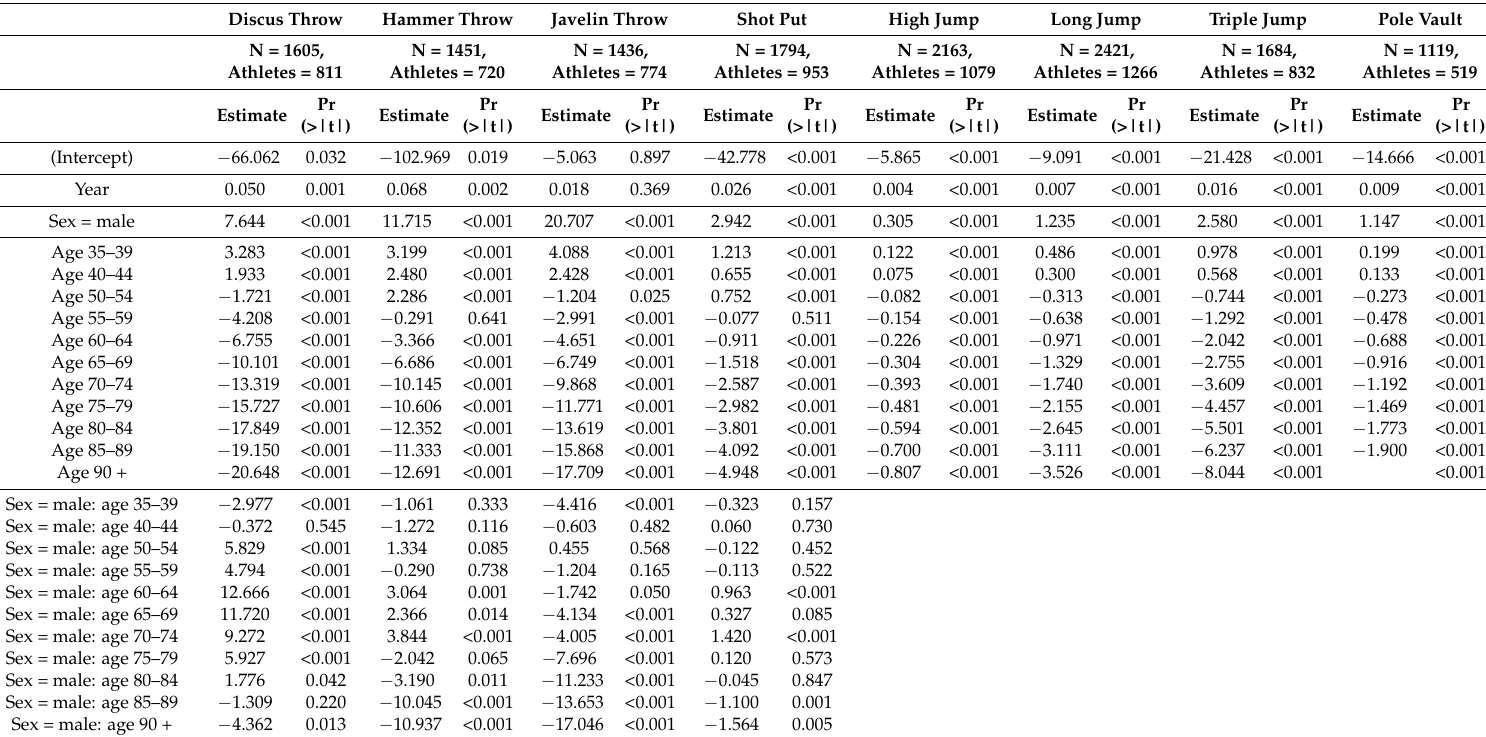
Table 2. The estimates and p -values of fixed effects of mixed models of performance for each event. The effects on sex are reported with women being the reference sex group and the effects on age are shown with 45–49 years being the reference age